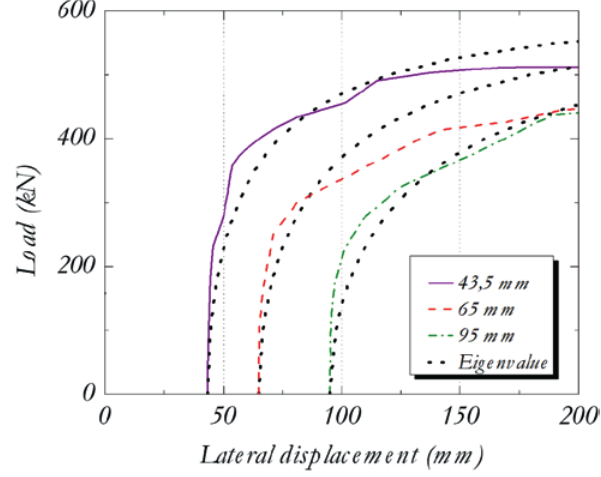
Numerical and analytical load-lateral displacement